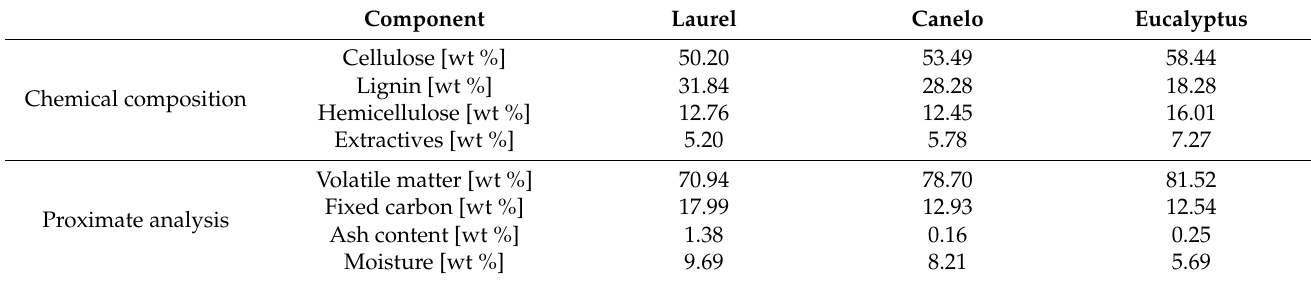
Table 1. Chemical composition and proximate analysis of the lignocellulosic biomass. Component Laurel